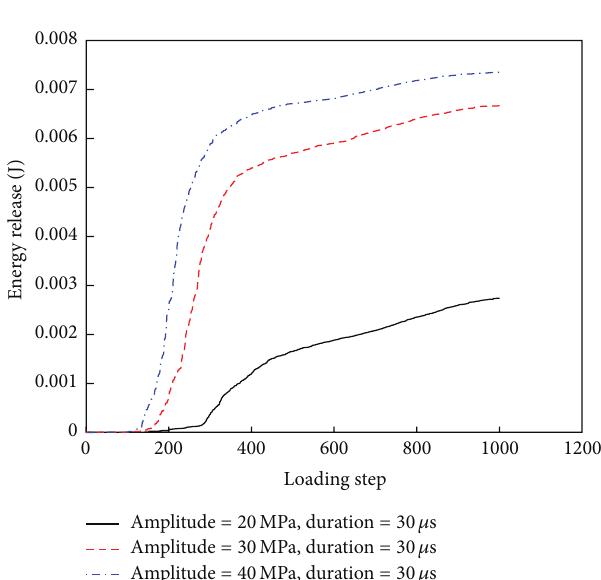
Figure 10: Variation of energy release of damaged elements of particle under different stress wave